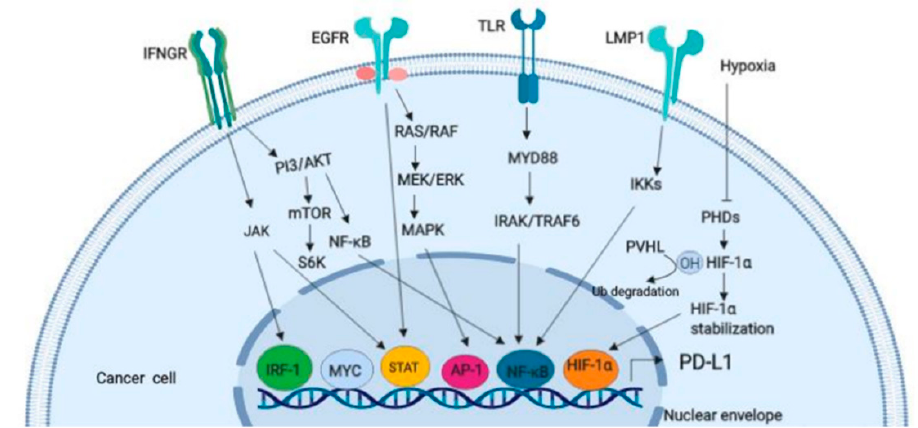
Figure 7. Signaling pathways for PD-L1 expression in cancer. Programmed death ligand-1 (PD-L1) is a cell surface receptor on cancer cells modulated by interferon gamma receptor (IFNGR), epidermal growth factor (EGFR), toll-like receptor (TLR), Epstein–Barr virus latent membrane protein (LMP1) and hypoxia.